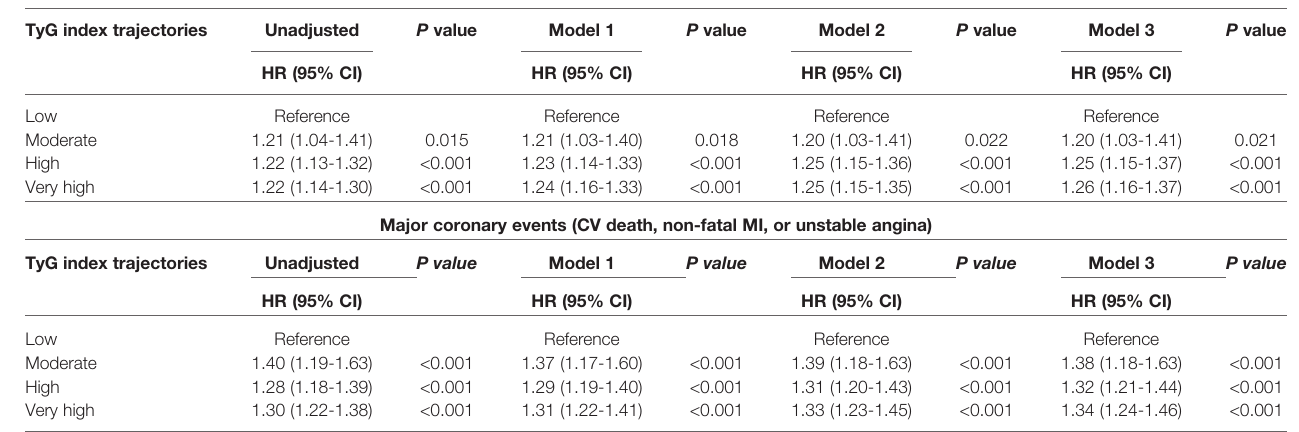
TABLE 3 | Risk of adverse CV and major coronary events for various levels of TyG index trajectory groups. MACEs (a composite of CV death, non-fatal MI, or non-fatal